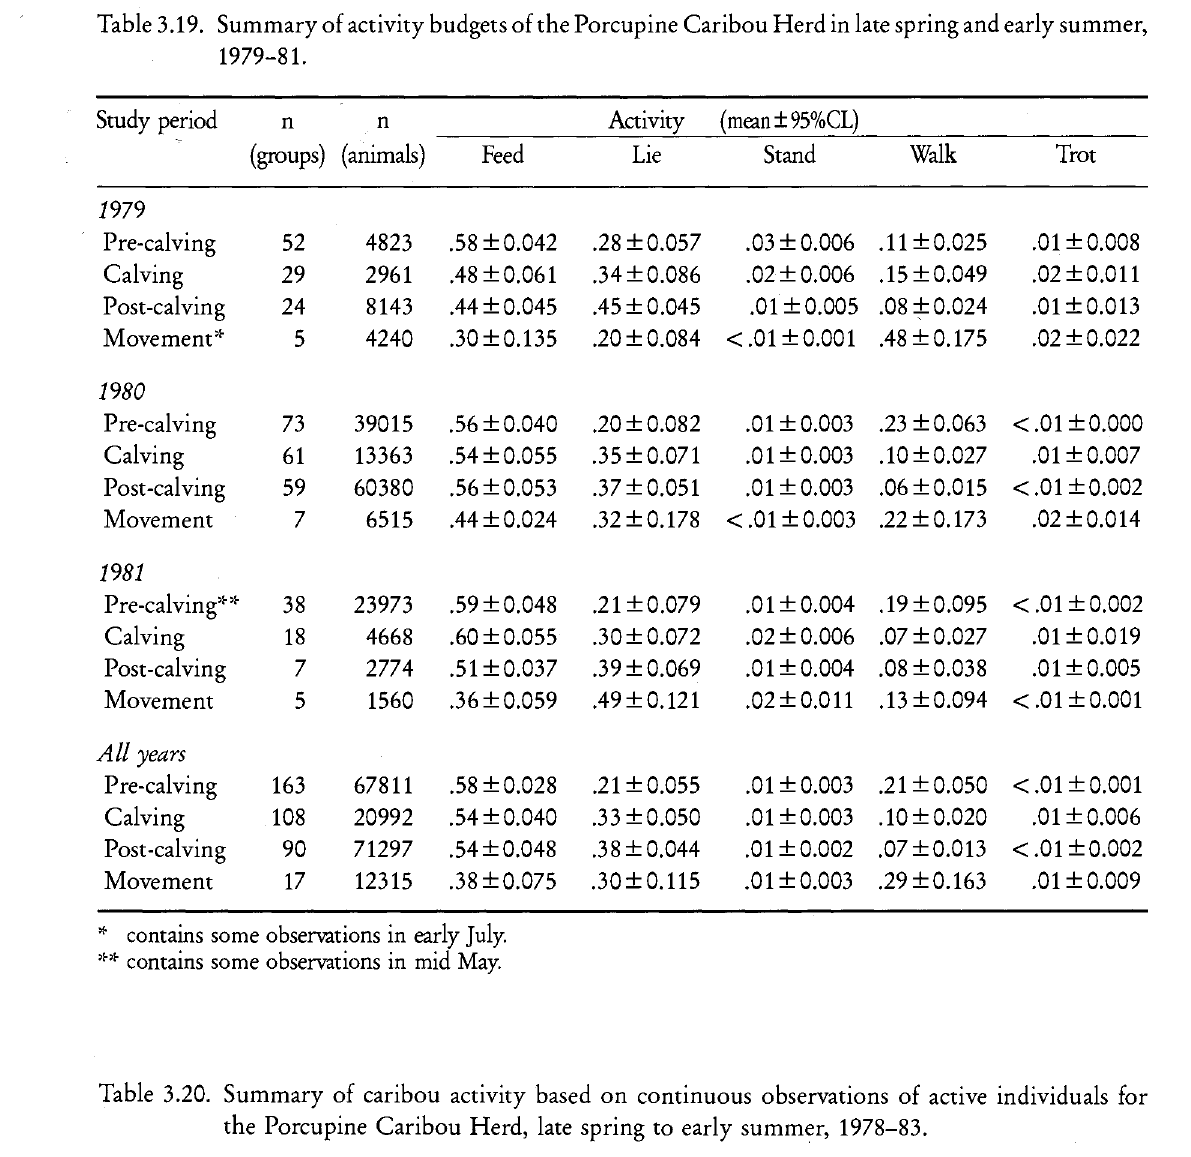
Table 3.20. Summary of caribou activity based on continuous observations of active individuals for the Porcupine Caribou Herd, late spring to early summer,